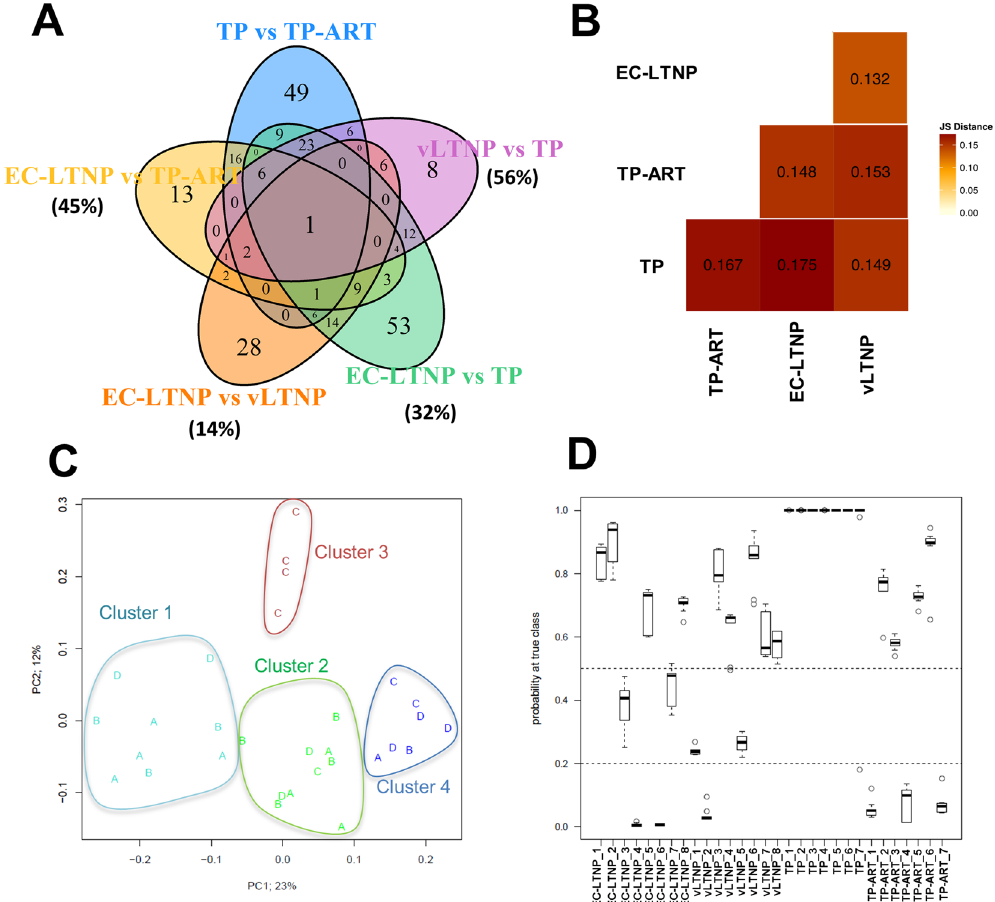
Figure 1. Comparison between phenotypes. Venn diagram showing overlapped DEGs found in several comparisons analyzed in the study (TP vs TP-ART, EC-LTNP vs TP-ART, EC-LTNP vs vLTNP, EC-LTNP vs TP and vLTNP vs TP). Only SLC37A3 were found in all the comparisons analyzed ( A ). Distance matrix showing similarities between phenotypes, calculated by the Jensen-Shannon divergence as implemented in the Bioconductor’s package cummerbund ( B ). Multidimensional scaling (MDS) plot of the 30 samples based on the first two principal coordinates (PC, x and y axes). Labels A, B, C and D correspond to EC-LTNP, vLTNP, TP and TP-ART phenotypes, respectively. Color code is based on k-means clustering results with N = 4. The percentage of variability explained by each PC is indicated ( C ). Probabilities to be correctly classified for each individual employing the 20 best predictive genes. A total of ten independent predictions were carried out with LOOCV and the distribution of these probabilities are showed. The majority of the individuals (n = 22, 73.3%) were correctly classified and 20 of them obtained p-values > 0.5 at true class after 10 repetitions (and therefore p-values < 0.5 for the sum of the probabilities to be classified as any of the 3 other false classes). At the other extreme, some other individuals were repeatedly incorrectly classified with all the p-values < 0.2 for the 10 models. This is the case for EC-LTNPs 4 and 6, vLTNP 2 and TP-ARTs 1, 4 and 7. EC-LTNP 4 and 6 were classified as vLTNPs for all the repetitions whereas the vLTNP 2 was classified as EC-LTNP also in all the iterations. In the case of the three TP-ARTs erroneously classified (1, 4 and 7), two of them were classified as EC-LTNPs and the other one as vLTNP. Between these two situations, 2 individuals (vLTNPs 1 and 5) were ambiguously classified with p-values at true class below 0.3 and with similar p-values to be classified as EC- LTNPs. The 10 models were able to classify correctly all the TPs with p-values close to 1 in all cases (except 1 out of the 10 models for TP 7 which was classified as vLTNP) ( D